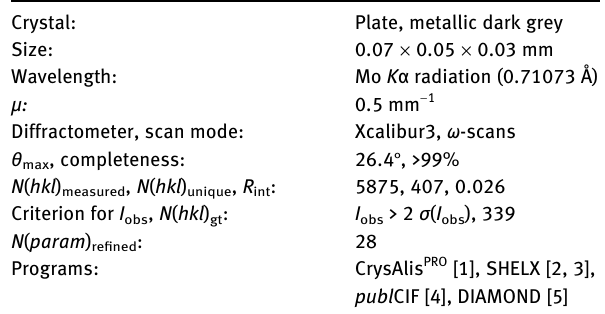
Table  : Data collection and